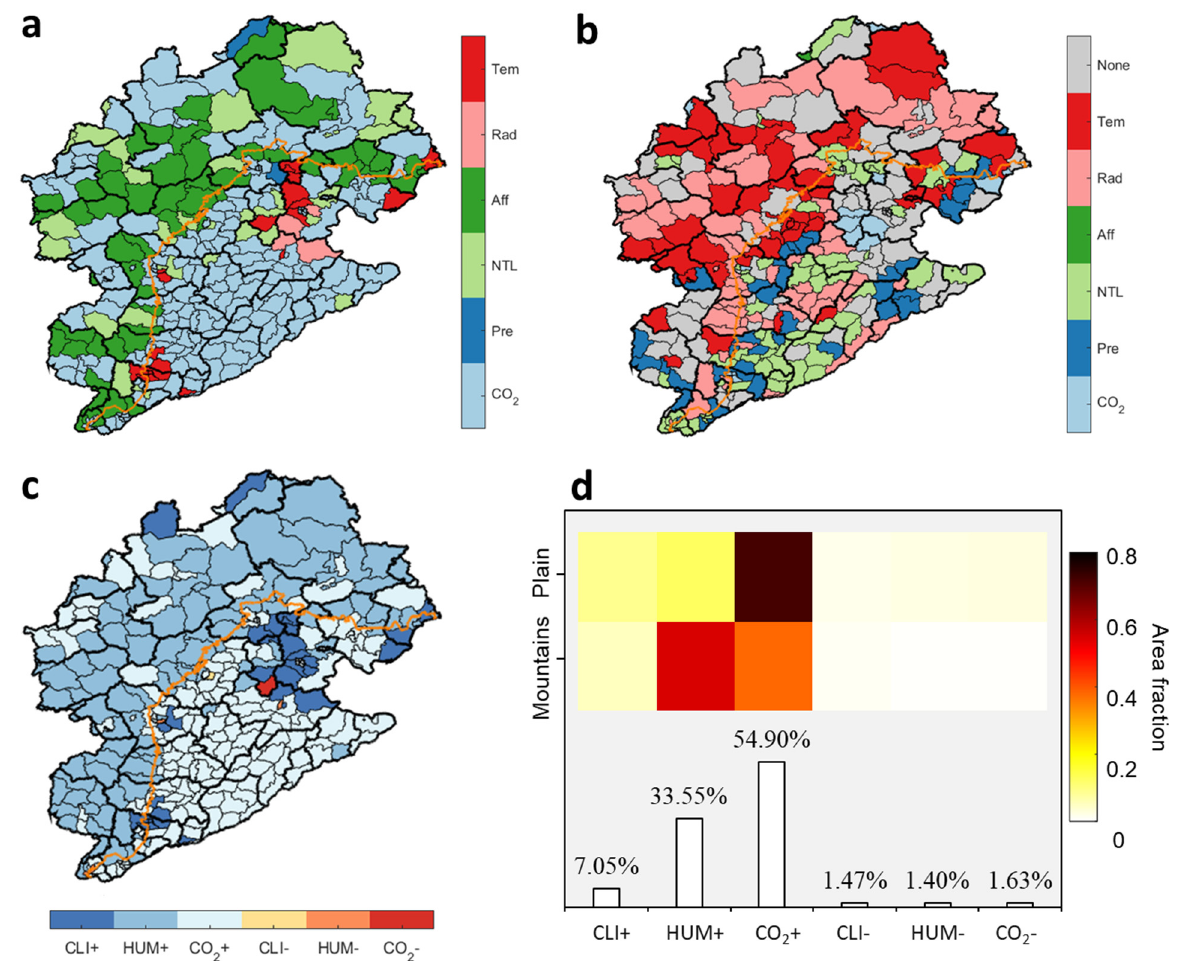
Figure 7. Dominant variable to ( a ) normalized difference vegetation index (NDVI) increase and ( b ) NDVI decrease. ( c ) Spatial distribution of driving contributors (CO 2 : rising CO 2 , CLI: climate change, and HUM: human activities) to NDVI trends. ( d ) Fractional area (%) of counties ascribed to different contributors over mountainous and plain areas. The label at the top of the bar is the fraction of counties dominantly driven by each contributor. A postfix ‘+’ indicates a positive effect on NDVI trends, whereas ‘ − ’ indicates a negative effect.